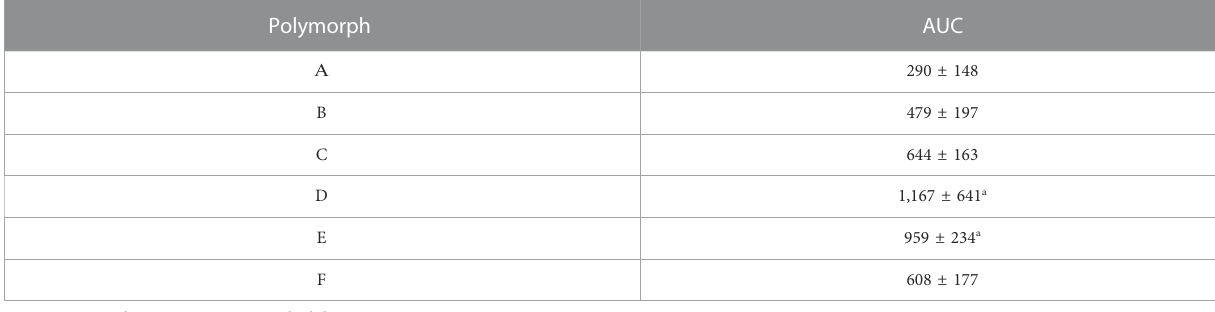
TABLE 5 Blood serum AUC values calculated by the trapezoidal method.